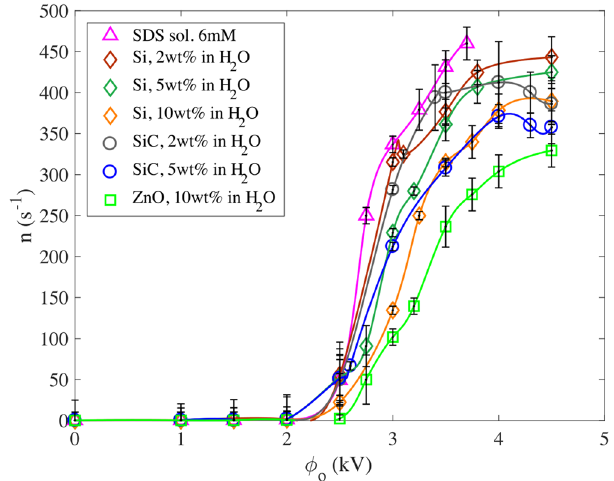
Figure 5. Meniscus frequency vs applied electric voltage. Markers represent the average meniscus frequency as a function of the applied voltage between the capillary tube and the earthed electrodes. Error bars show the uncertainty of the measurements with a confidence interval of 95%. Solid curves are produced by curve fitting the experimental